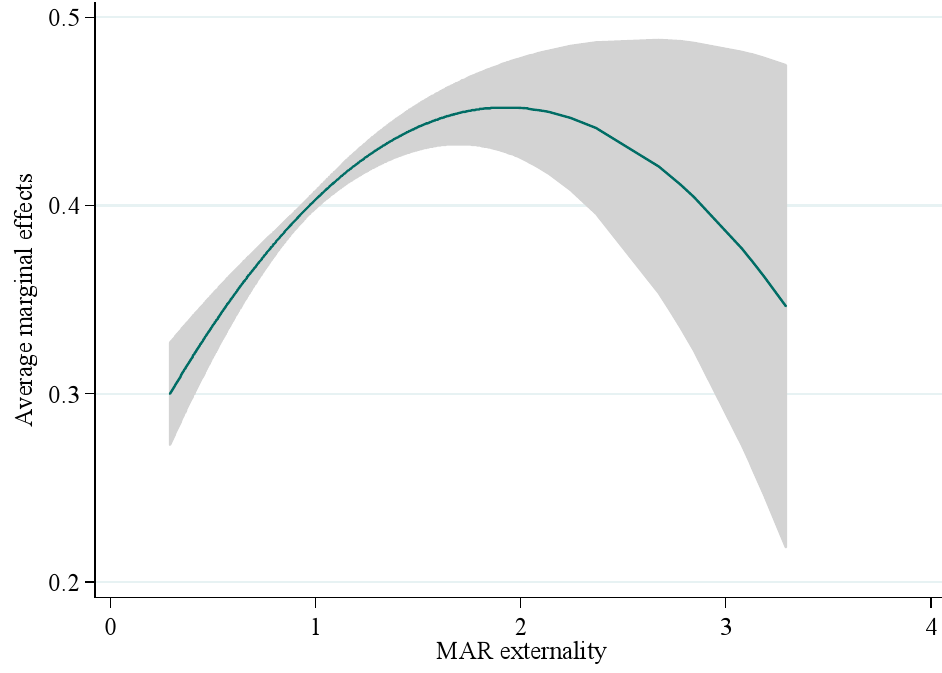
Figure 3. The average marginal effects of MAR externality on eco-efficiency.